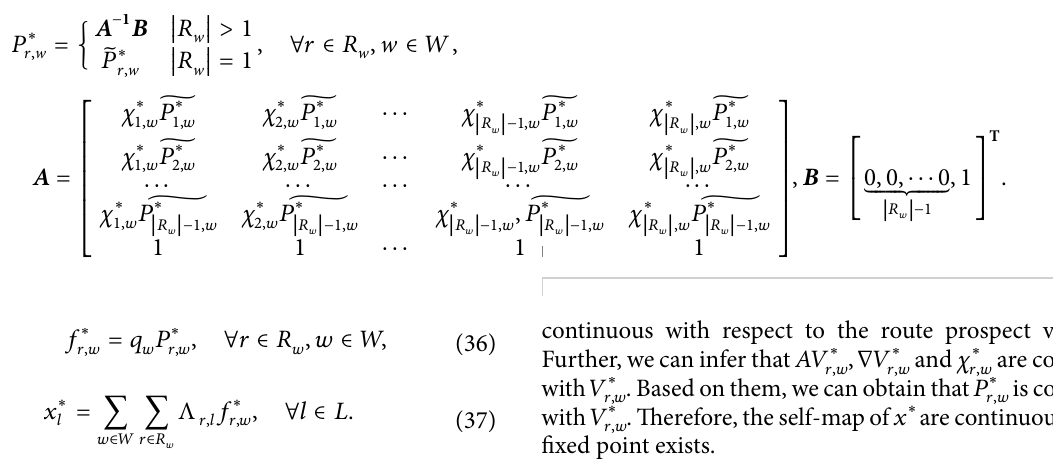
Figure 3: Evolutionary system with different learning rates. (a) λ = 0.1 and (b) λ =